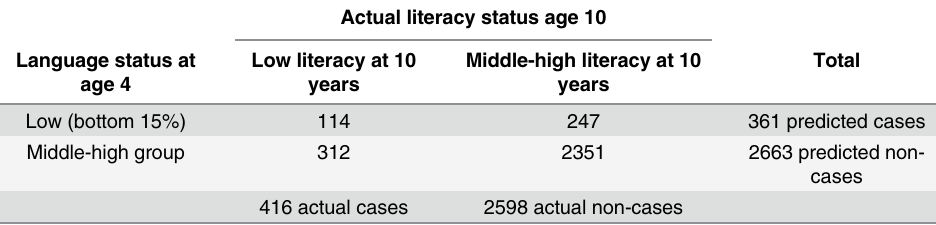
Table 6. Predicting literacy at age 10 from vocabulary at age